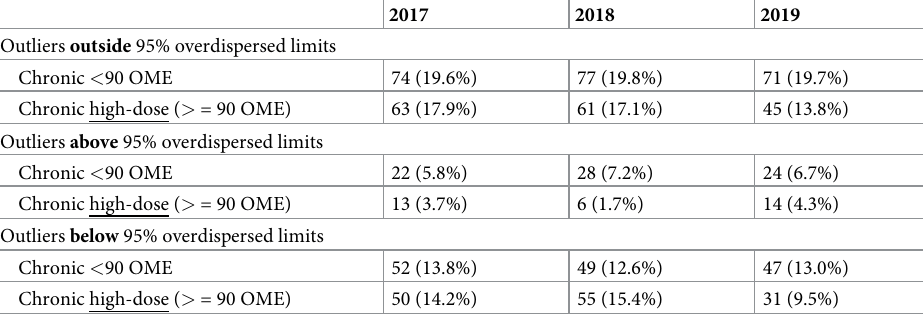
Table 3. Number of outliers in the funnel plots for all years and